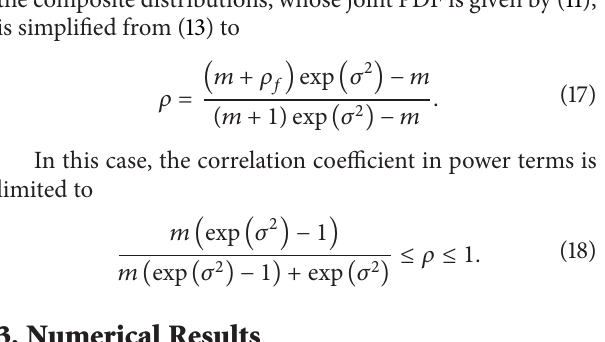
Figure 1: Cross-correlation shadowing